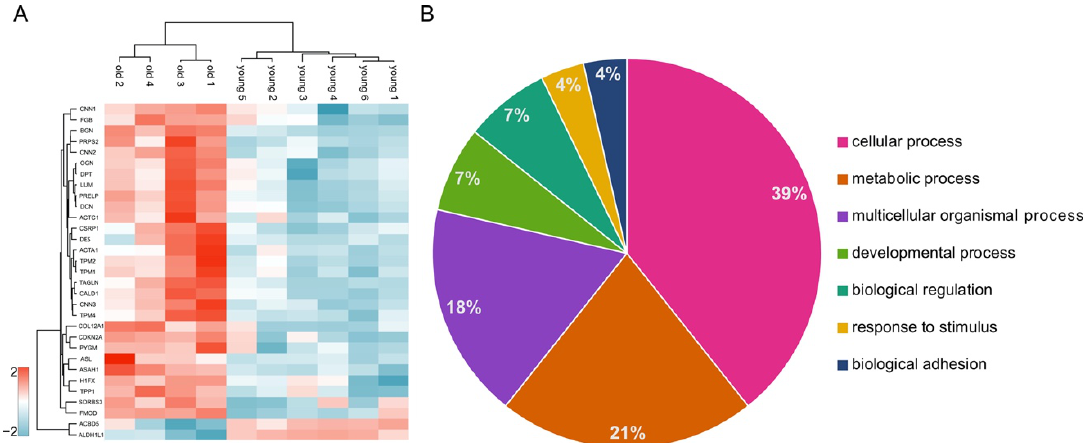
Figure 3. ( A ) Heatmap and unsupervised hierarchical clustering of differentially abundant proteins for the comparison old